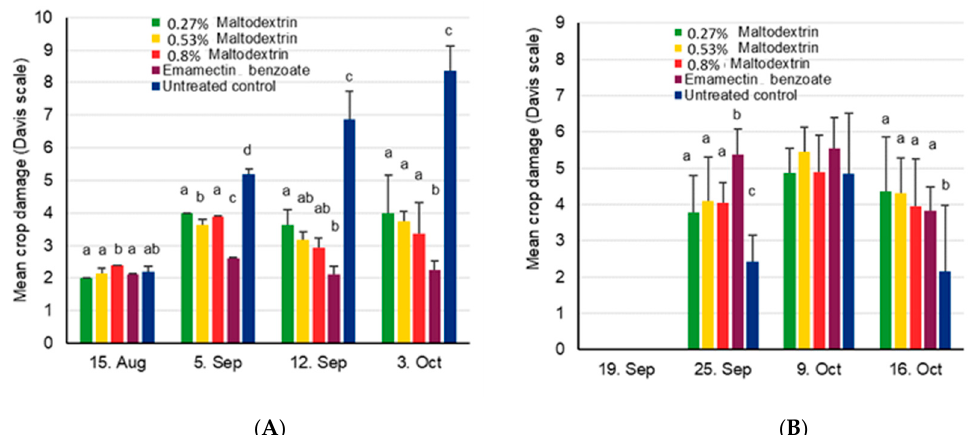
Figure 2. Mean crop damage induced by FAW + SD found in the maltodextrin trial during vegetative growing stages conducted in 2018. Within a given date, bars sharing the same letters are not significantly different from each other. If no letters are shown, this indicates that no differences were found. ( A ) Site 1 near Wa, Upper West, Ghana, where treatments were applied on 16 August, 6 September, and 27 September. ( B ) Site 2 near Accra, Ghana, where treatments were applied on 20 September and 10 October.